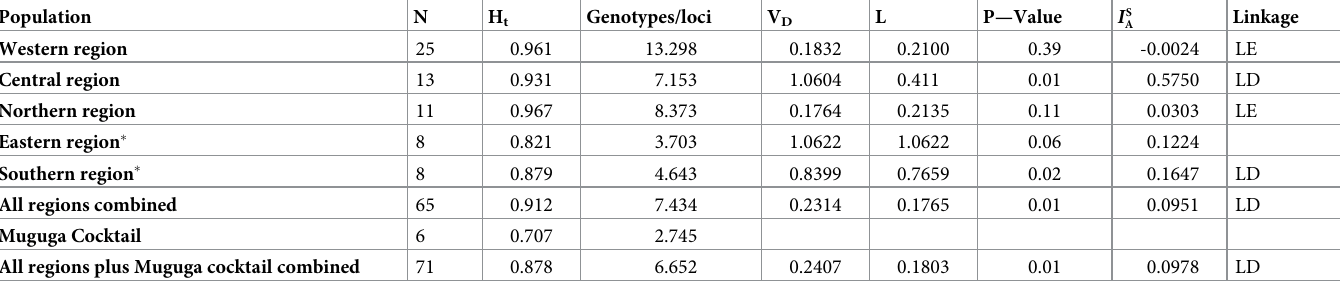
Table 6. Genetic analyses of field samples from the Western, Central, Northern, Eastern and Southern regions of Burundi and the Muguga cocktail (Muguga, Kiambu and Serengeti as well as the MCL01) vaccine.